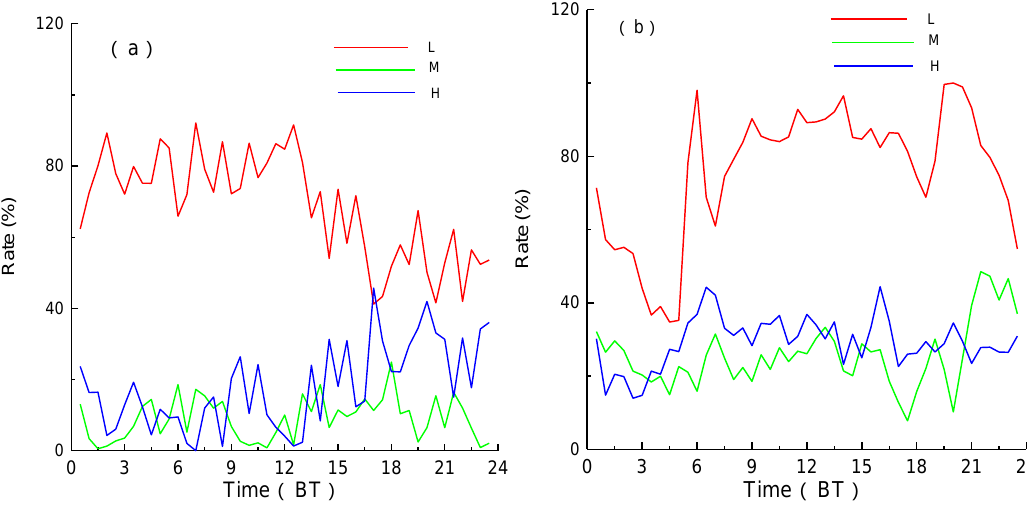
Figure 17. Diurnal variations of cloud occurrence frequencies of low-altitude (L in red), mid-altitude (M in green) and high-altitude (H in blue) clouds from ( a ) the merged data; and ( b ) the CEIL observations.